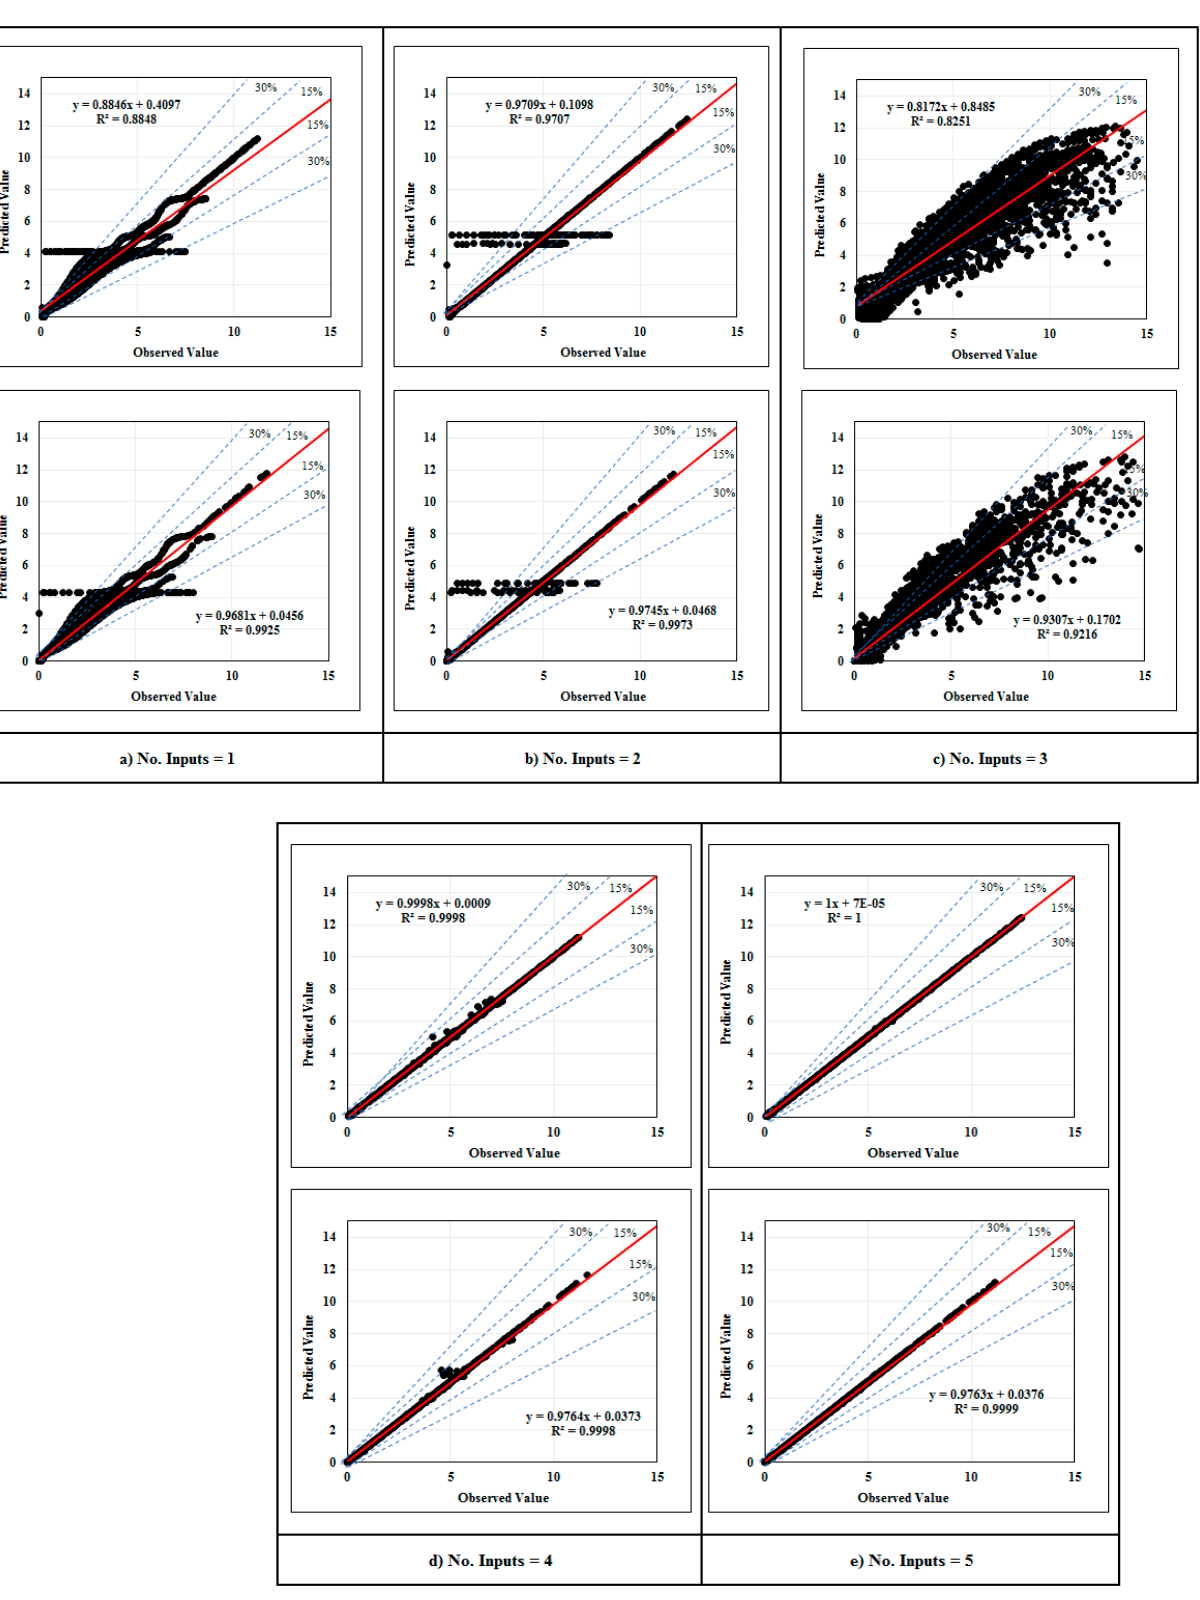
Figure 24. Regression of the training (above charts) and testing (below charts) phase results with measured values of displacement for ( a ) one input, ( b ) two inputs, ( c ) three inputs, ( d ) four inputs, ( e ) five inputs.